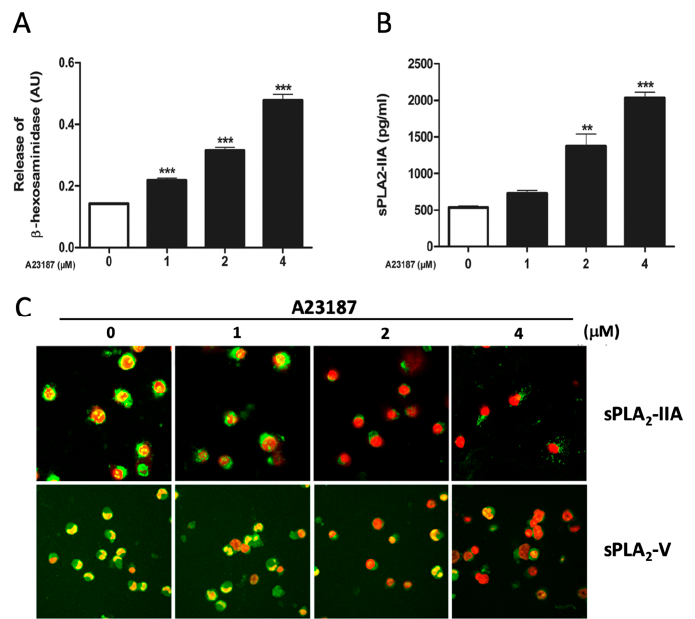
Figure 5. Degranulation and release of sPLA 2 -IIA and sPLA 2 -V in A23187-stimulated HMC-1. Cells were stimulated for 4 h with various concentrations of calcium ionophore A23187. Control cells were incubated with culture medium only. ( A ) Release of β -hexosaminidase. ( B ) ELISA analysis. Release of sPLA 2 -IIA. ( C ) Immunocytochemical analysis, visualizing the effect of A23187 on the release of sPLA 2 -IIA and sPLA 2 -V. Green staining is for sPLA 2 -IIA or sPLA 2 -V and red staining is for visualization of cell nuclei (magnification × 600). Note that the expression of sPLA 2 -V had to be upregulated by TNF α , as described in Figure 2A and B. ** p < 0.01, *** p < 0.001 vs. controls. Data from three independent experiments. Cells 2019 , 8 , x FOR PEER REVIEW